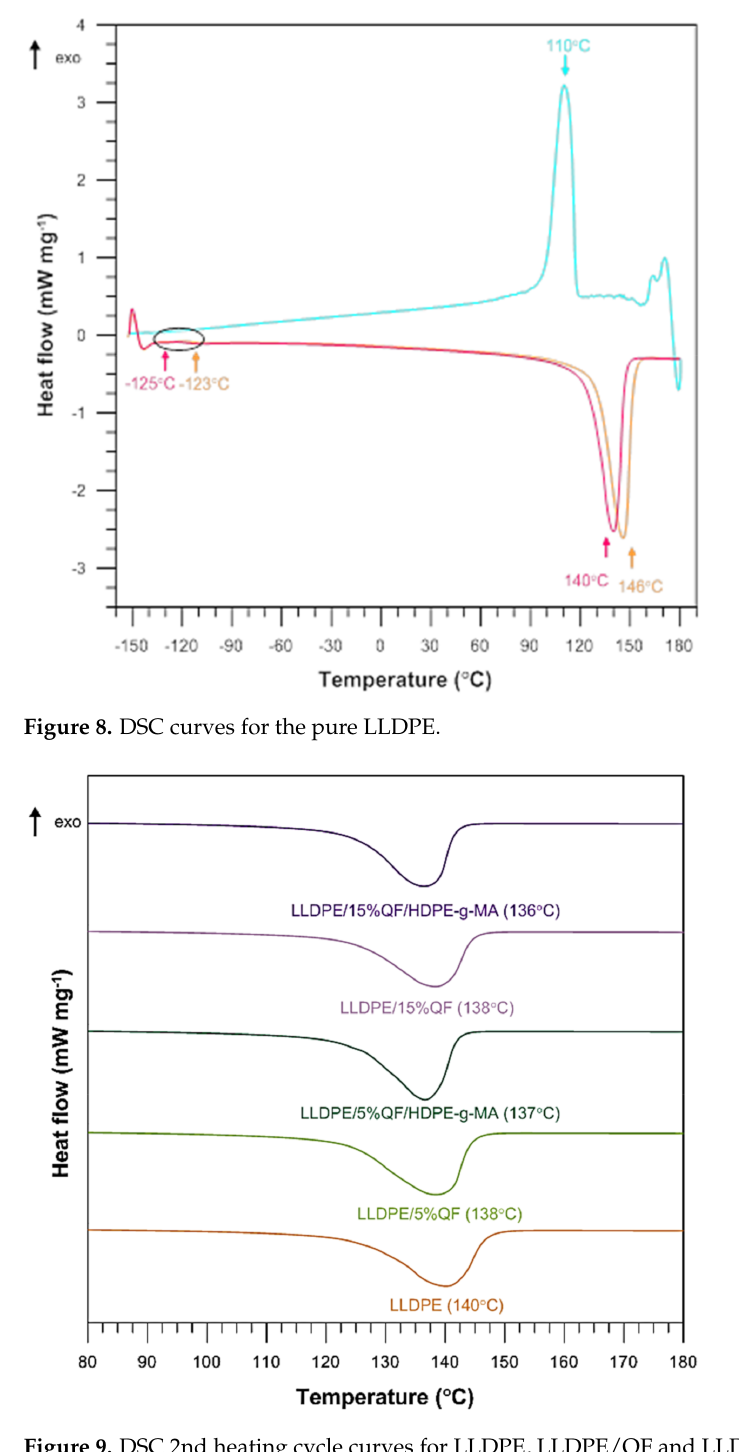
Figure 9. DSC 2nd heating cycle curves for LLDPE, LLDPE/QF and